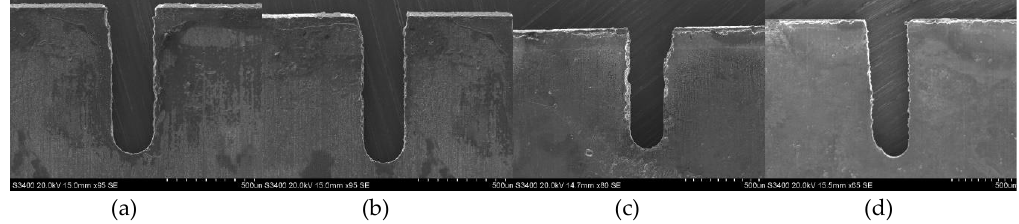
Figure 10. The slits machined by voltage feed rate combinations, utilizing an electrode diameter of 0.2 mm: ( a ) 7 V–0.3 μm/s; ( b ) 7.5 V–0.3 μm/s; ( c ) 8 V–0.7 μm/s; ( d ) 8.5 V–0.8 μm/s.